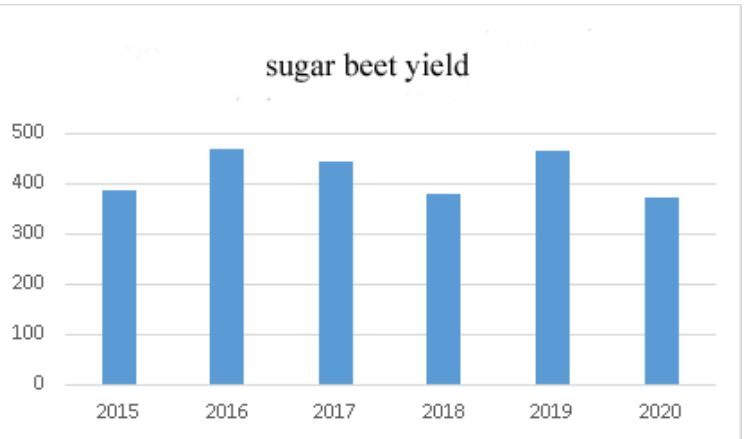
Figure 18. Productivity of sugar beet c/ha harvested area in the Russian Federation. Producers choose favorable regions of the country for sowing and growing root crops. This is mainly the southern part of Russia, particularly the Krasnodar